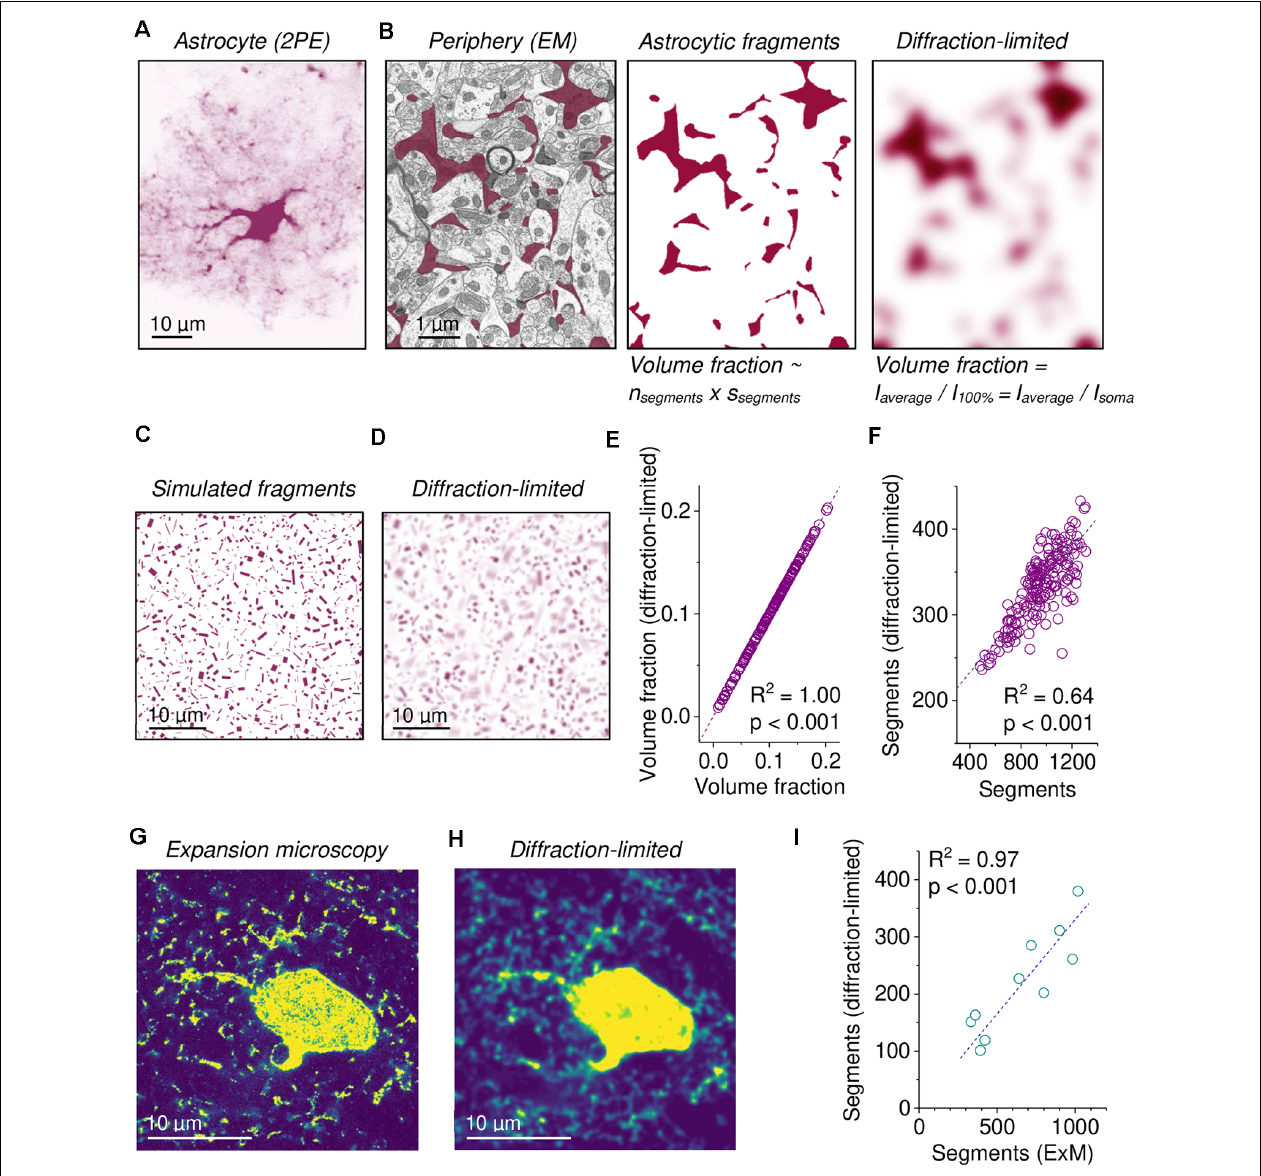
FIGURE 1 | Assessing fine astroglial morphology in diffraction-limited microscopy by measuring astroglial volume fraction (VF) and segment density. (A) Example of a single EGFP-expressing astrocyte imaged using diffraction-limited two-photon excitation (2PE) fluorescence microscopy (single focal plane through the soma). Note the blurry periphery representing small astroglial processes. (B) Left panel: example of an electron micrograph of the hippocampal neuropil with clearly delineated astrocyte fragments highlighted in purple (left panel). For further experimental details see Medvedev et al. (2014). Middle panel: same section only showing astrocyte fragments. The fraction of the section that is occupied by astroglial segments is the product of their number (n segments ) and average size (s segments ) divided by the total area. Right panel: diffraction-limited microscopy was illustrated by applying a Gaussian filter with a FWHM of 500 nm. Astrocyte fragments cannot be clearly separated and counted. The fraction of occupied area/volume can be calculated by normalizing the average intensity (I average ) to the value corresponding to 100% (I 100% ). (C) An example of a single section at full resolution cutting through simulated astrocyte processes of various sizes and orientations in a simulated image stack (see text and methods). (D) Emulation of diffraction-limited fluorescence imaging of the image stack from (C) . Note that this is not a smoothed version of (C) but instead representative of diffraction-limited imaging of the entire stack. Also, note the now blurry and overlapping astrocyte processes. (E) The VF obtained from simulated diffraction-limited microscopy (I average /I 100% ) strongly depends on the original fraction of volume occupied by astrocyte processes (linear fit, n = 190 separate sets of astrocyte processes). (F) The number of detectable astrocyte segments was determined (see text and methods) in simulations of diffraction-limited microscopy (D) . The number of detected segments was smaller than the number of simulated astrocyte processes but showed a highly significant positive correlation (linear fit, same data set as in (E) . (G) Example of super-resolution expansion microscopy (ExM) of an EGFP-expressing astrocyte (single focal plane from a stack). Note the high level of detail. (H) Simulation of diffraction-limited microscopy of ExM data (same cell as in G ). Note the appearance of out-of-focus structures and blurring. (I) The number of astrocyte segments determined in ExM was lower after simulation of diffraction-limited imaging but strongly correlated with the number obtained directly from ExM data (linear fit, n = 10 independent experiments).